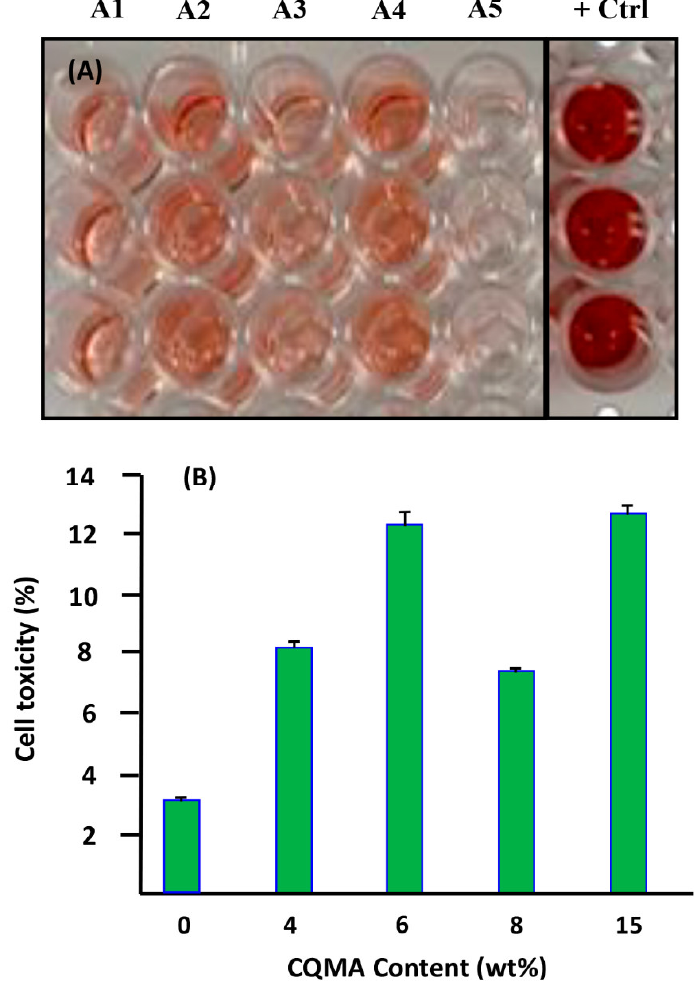
Figure 13. Effect of CQMA- co -HEMA on Ca9-22 cells cytotoxicity of different CQMA contents. ( A ) LDH assay. ( B ) Representative figure of percentage of cell toxicity with different CQMA contents.